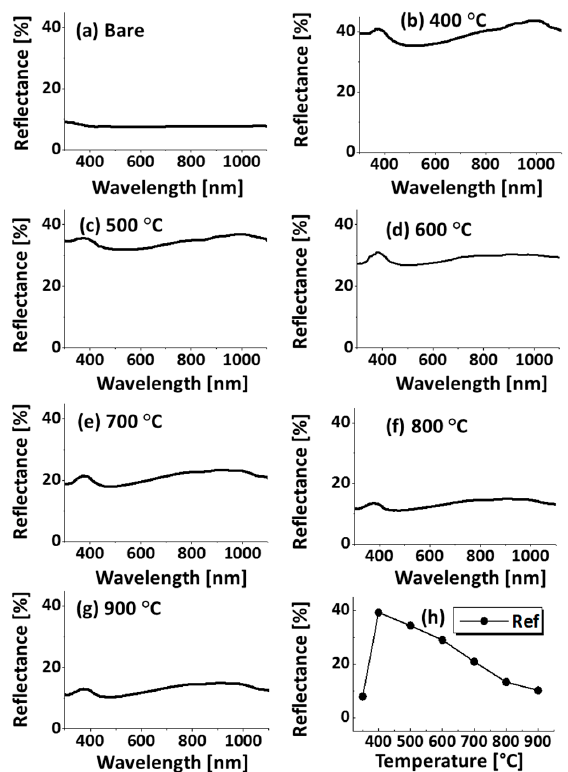
Figure A5. ( a – g ) Reflectance spectra of the bare sapphire (0001) and samples shown in Figure A3; ( h ) summary of average reflectance with respect to the temperature.